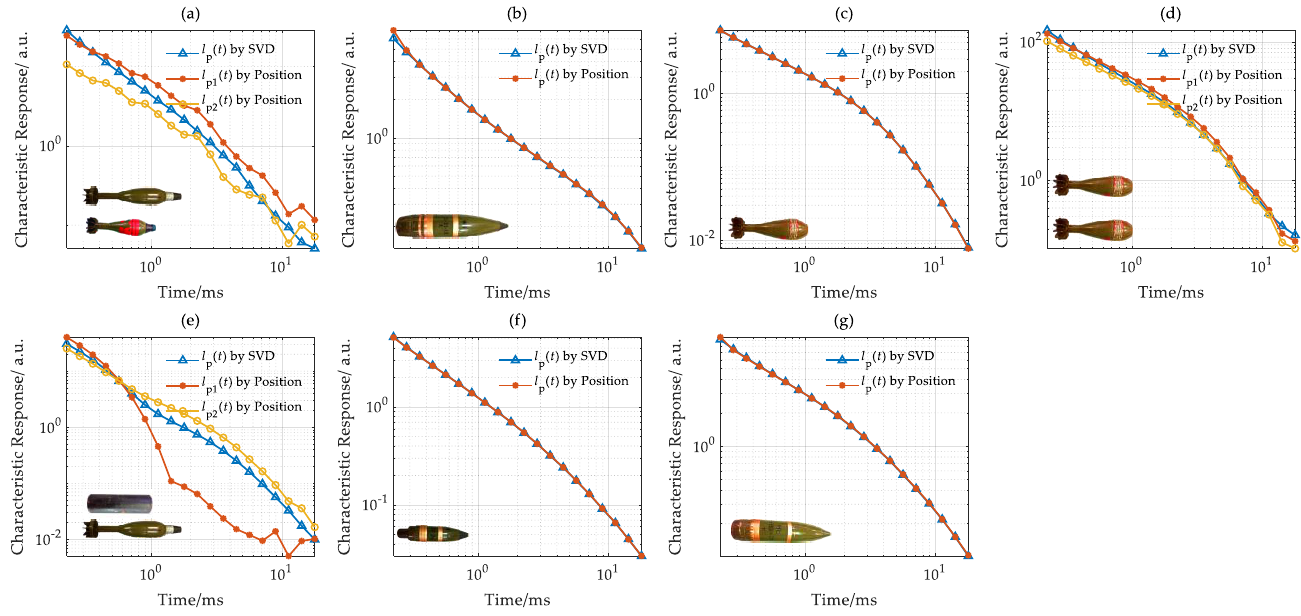
Figure 13. Characteristic response in the survey line with y = 3.0 m. ( a ) U5 and U3, ( b ) U7, ( c ) U4, ( d ) U4, ( e ) O6 and U5, ( f ) U2, ( g )